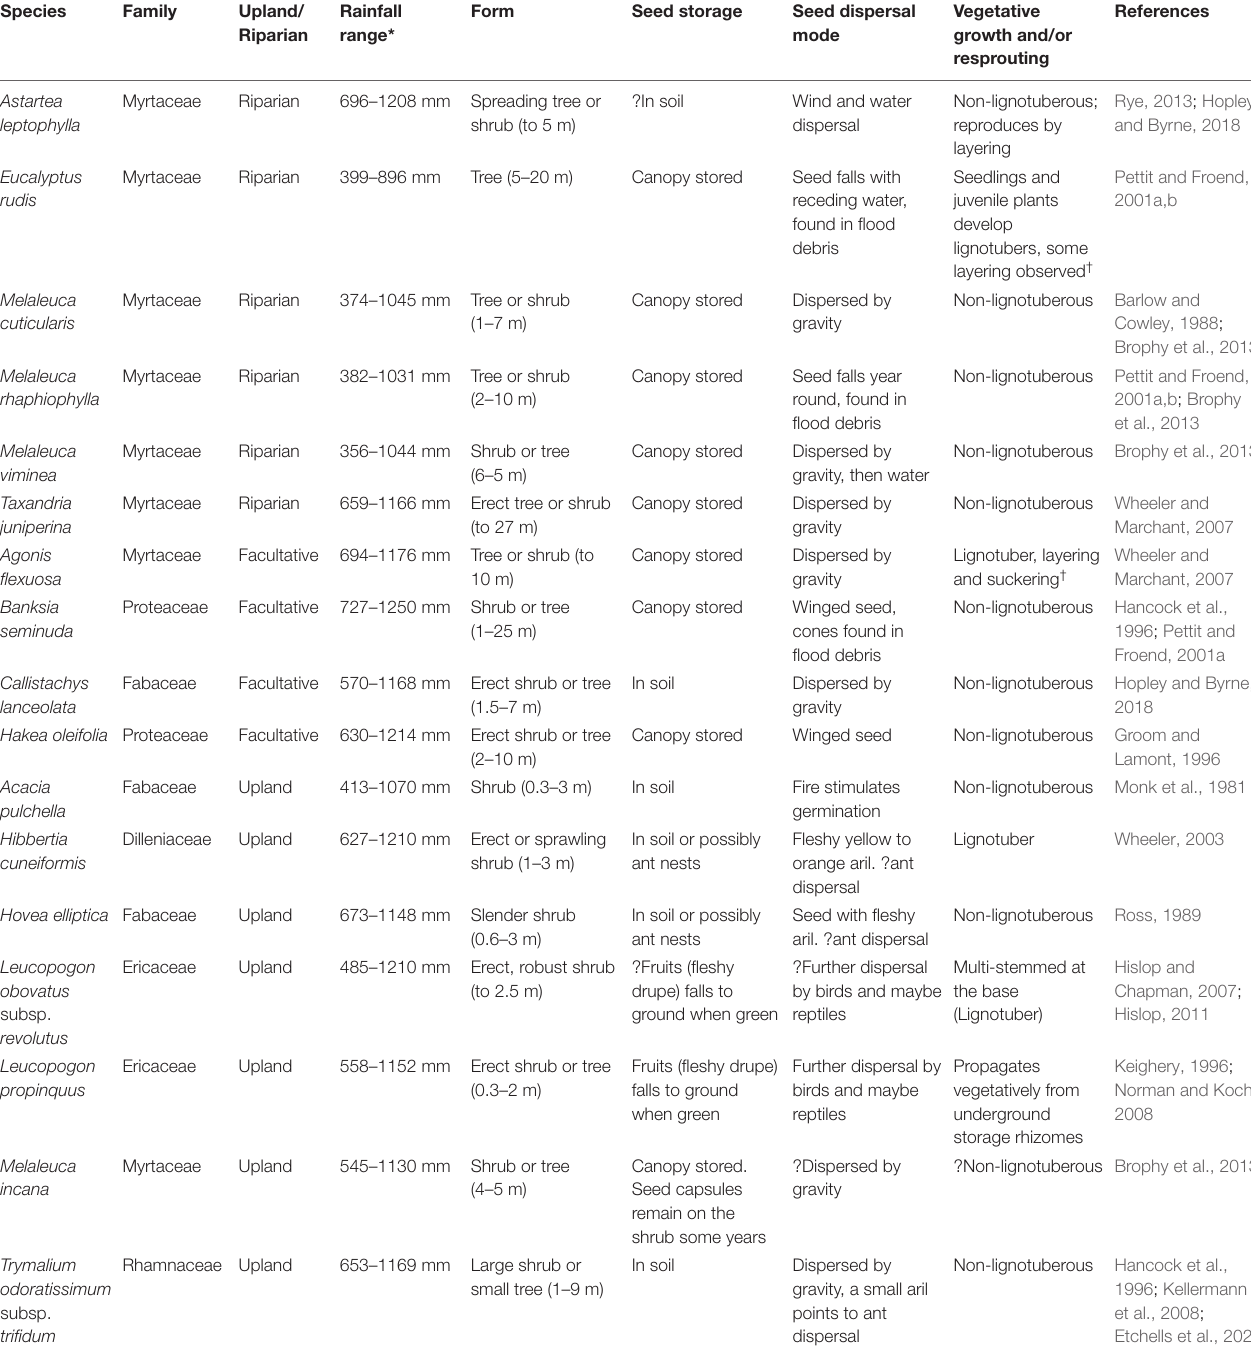
TABLE 1 | Habitat and reproductive traits of the woody trees and shrubs common to the riparian zone of the Warren River